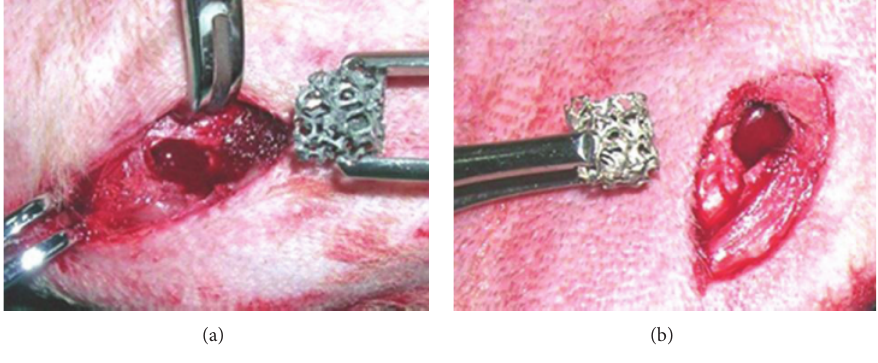
Figure 2: Placement of the